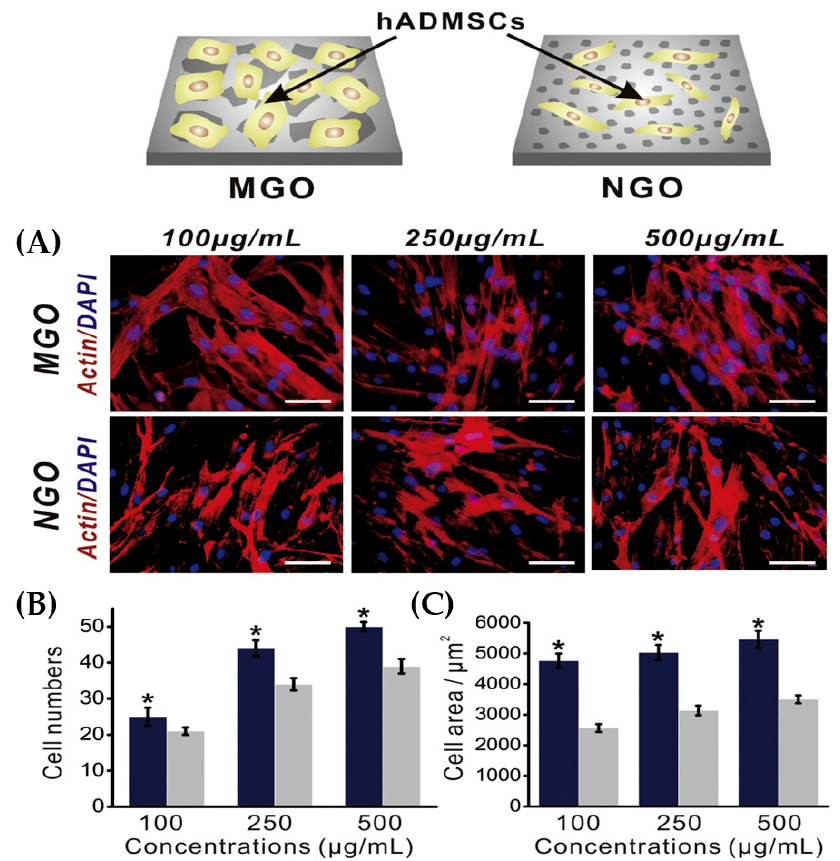
Figure 6. Size effects on human adipose-derived MSCs using micro and nano-sized GO substrates presenting enhanced proliferation rates of 100, 250 and 500 μ g/mL ( A ) 2 days of proliferation, ( B ) cell population and ( C ) proliferated cell areas after 2 days of proliferation (* p < 0.05, n = 3; navy: MGO, gray: NGO) [111].